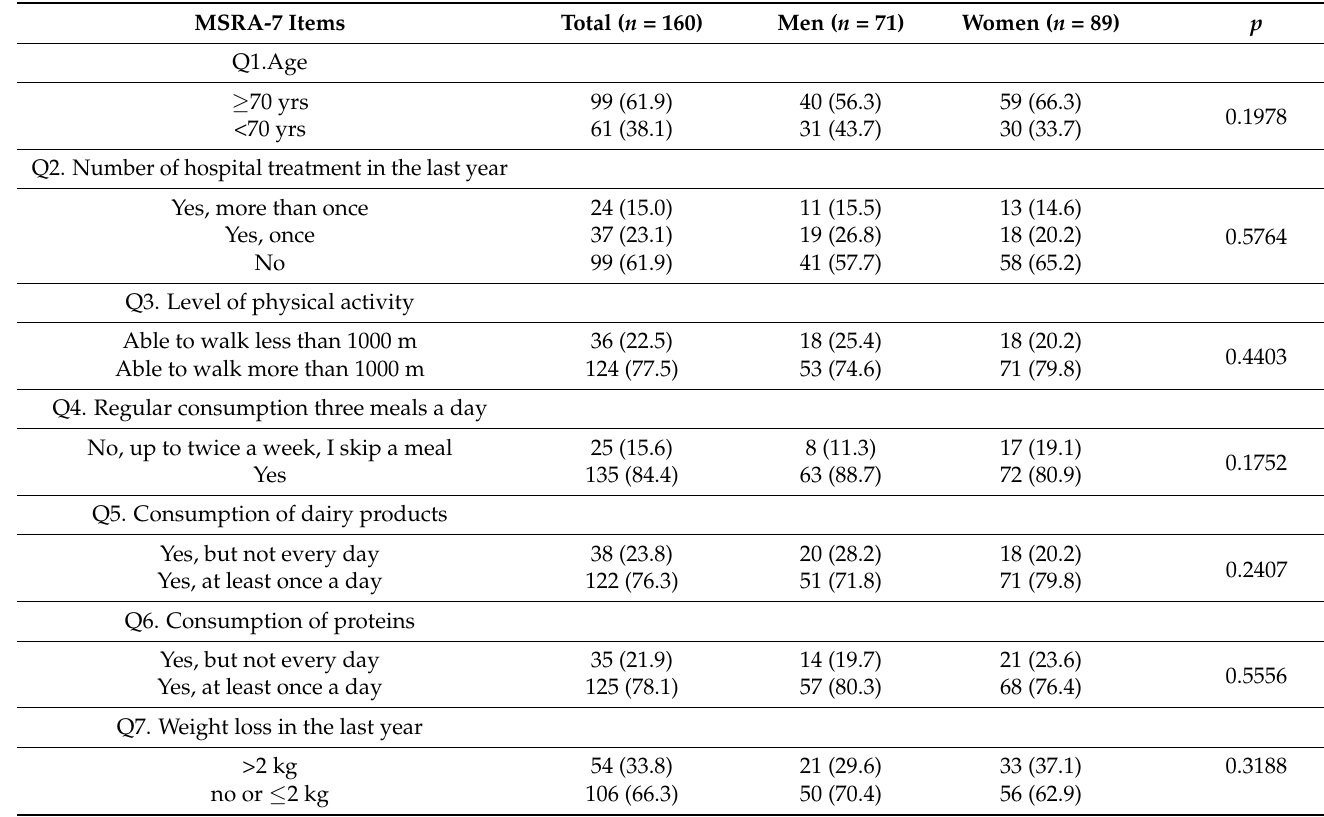
Table 4. The answers to the Mini Sarcopenia Risk Assessment (MSRA) questions—the whole study population and according to